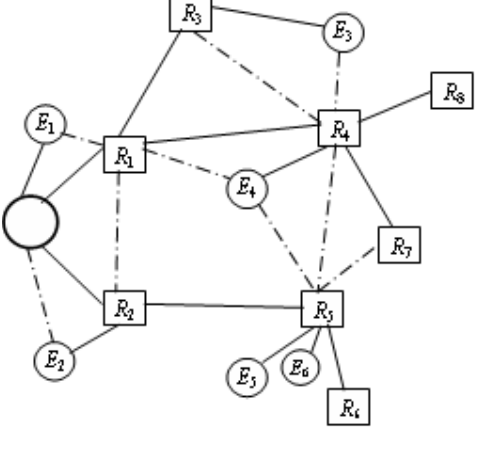
Figure 2. Connection of the unconnected device after node